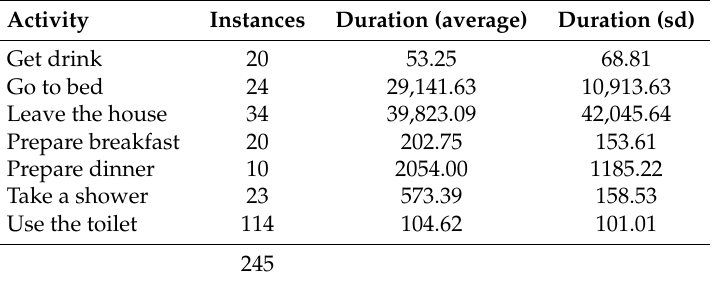
Table 3. Instances per activity in the dataset.